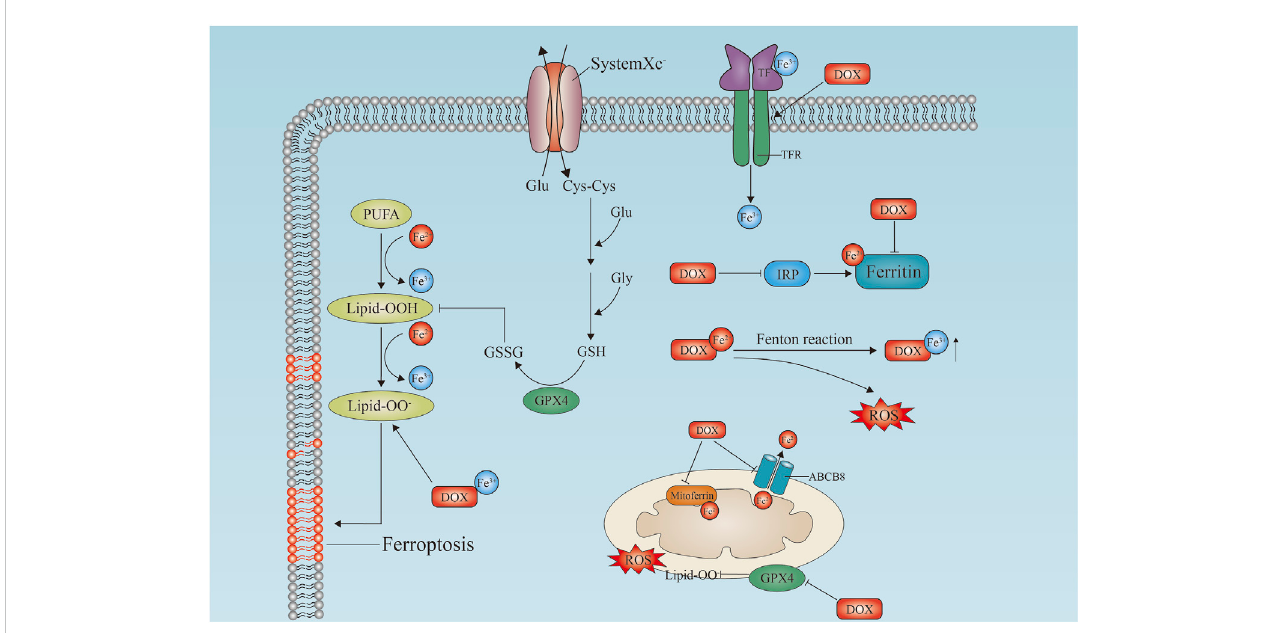
FIGURE 2 Doxorubicin-induced ferroptosis in cardiomyocytes. Schematic diagram of the doxorubicin-induced ferroptosis pathway in cardiomyocytes. Doxorubicin upregulates TfR and inactivates ferritin, which induces lipid peroxidation by inhibiting GPX4 in cell membranes and mitochondria, leading to ferroptosis. Free iron binds to doxorubicin to generate reactive oxygen species (ROS). In mitochondria, doxorubicin causes iron overload by blocking MitoFer andABCB8.IRP,ironresponseregulatoryprotein;Tf,transferrin;TfR,transferrinreceptor;Lipid-OO,lipidperoxidation;PUFA,polyunsaturatedfattyacid; GSH, reduced glutathione; GSSG, glutathione disul fi de; GPX4, glutathione Peroxidase; MitoFerrin, mitochondria ferritin; ABCB8, ATP-binding cassette transporter eight; ROS, reactive oxygen species; DOX,